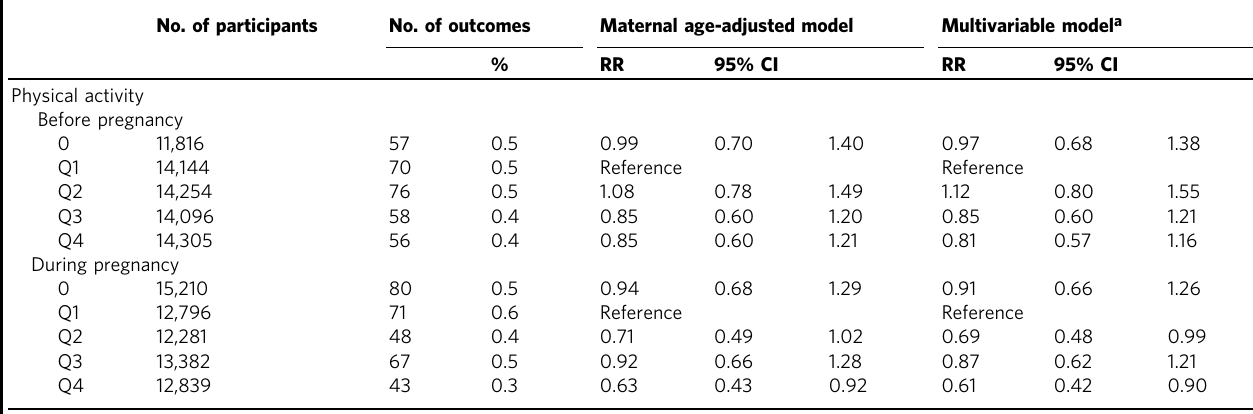
Table 1 Association between maternal physical activity before or during pregnancy and diagnosis of autism spectrum disorder in infants aged 3 years (parent-reported; Japan Environment and Children ’ s